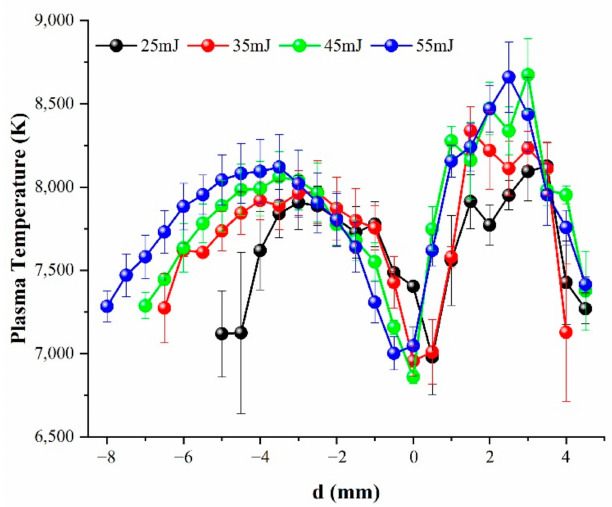
Figure 6. Effect of pulse energies and d on the Cu plasma temperature (the error bar is derived from the ratio of line 521.82 nm to 510.55 nm, and the ratio of line 515.32 nm to